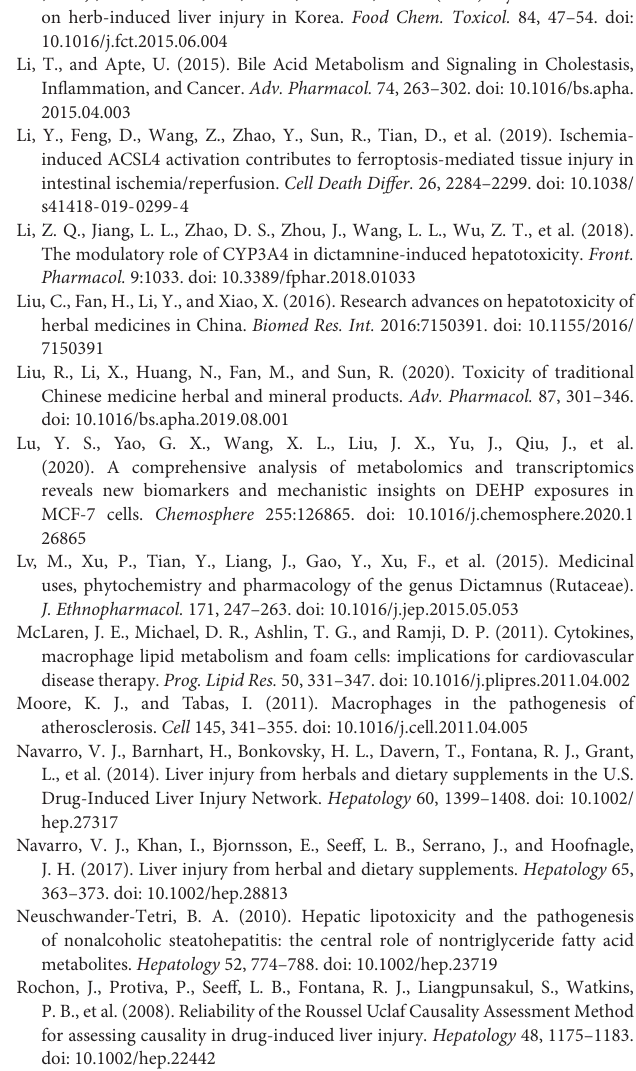
Supplementary Figure 1 | RNA-seq analysis in vitro and vivo . (A) GO analysis of RNA-seq data of HepaRG cells. (B) The volcano map of the differentially expressed genes in dictamnine-treated and untreated control mice. (C) Enriched GO terms of RNA-seq of male and female ICR mice. (D) Correlation and clustering of RNA-seq data of male and female ICR mice. (E) Enriched KEGG terms of RNA-seq of dictamnine-treated and untreated female ICR mice. (F) The top enriched KEGG terms of RNA-seq from dictamnine treated and untreated female ICR mice. Supplementary Figure 2 | ROC curves of the differentially expressed metabolites. (A) Receiver-operating-characteristic (ROC) curve showing the area under the curve (AUC) for the 28 differentially expressed metabolites between the control (Con) and dictamnine (Dic) group. The color indicates the value of AUC. (B) ROC curves for the 13 differentially expressed metabolites between dictamnine-treated mice and untreated control. (C) Quantification of the high value biomarkers ( ∗ P < 0.05, ∗∗ P < 0.01, vs. Con.). Supplementary Figure 3 | The serum ALT and AST activities of dictamnine-induced liver injury in